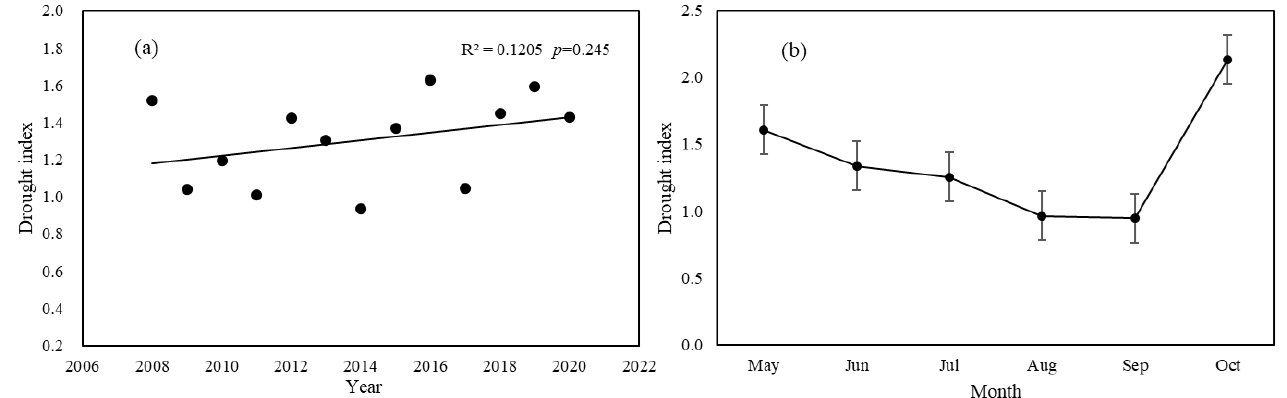
Figure 7. Inter- and intra-annual variation of drought index. ( a ) indicates interannual variation of evapotranspiration, ( b ) indicates months’ variation of soil water deficit in growth season. Table 1. Response of soil moisture content to rainfall during a single rainfall